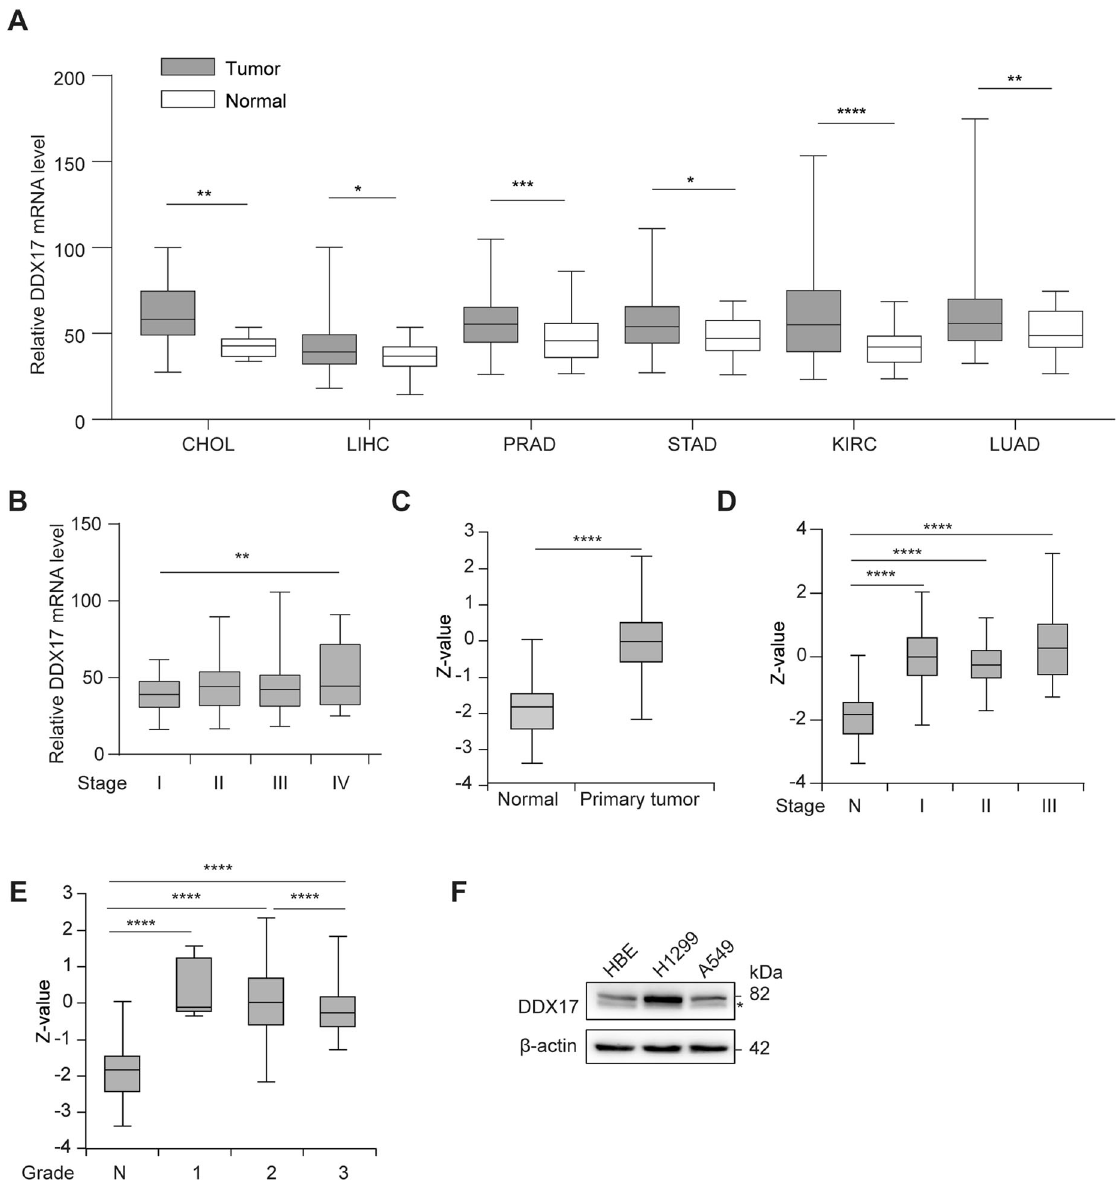
Fig. 1 DDX17 is overexpressed in various cancers. A mRNA level of DDX17 in various tumor compared with the corresponding normal tissues from TCGA database. CHOL cholangiocarcinoma, LIHC Liver Hepatocellular Carcinoma, PRAD Prostate Adenocarcinoma, KIRC Kidney Renal Clear Cell Carcinoma, STAD Stomach Adenocarcinoma, LUAD Lung adenocarcinoma. B mRNA levels of DDX17 in various stages of LUAD (data from TCGA). C – E The expression of DDX17 protein in different stages ( C , D ) and grades ( E ) of lung adenocarcinoma and normal tissues analyzed by UALCAN cancer database. Z -values represent standard deviations from the median across samples for the given cancer type. Log2 Spectral count ratio values from CPTAC were fi rst normalized within each sample pro fi le, then normalized across samples. *p < 0.05, **p < 0.01, ***p < 0.001, ****p < 0.0001, determined by two-tailed Student ’ s t -tests ( A , C ) or two-way ANOVA ( B , D , E ). F DDX17 protein expression was analyzed by western blot in HBE, A549, H1299 cell lines. Asterisk (*) symbol indicates nonspeci fi c